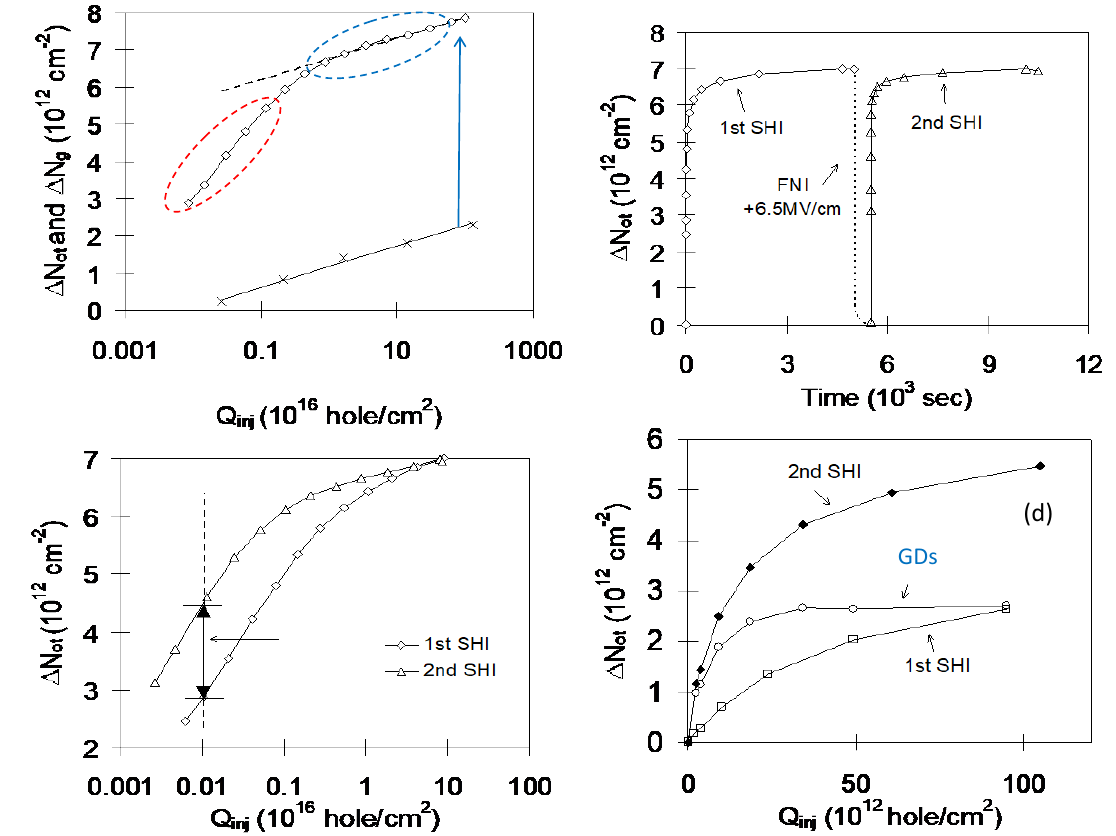
Figure 10. ( a ) The symbol “ ♦ ” represents defect build-up during stress. The symbol “ × ” represents generated defects extracted as shown in ( c , d ). ( b ) The test sequence: 1st stress, neutralization, and then 2nd stress. ( c ) The difference between the 1st and 2nd filling. The generated traps resulted in higher trapping during the 2nd filling. ( d ) The generated traps could be filled rapidly, and their filling was saturated [48].